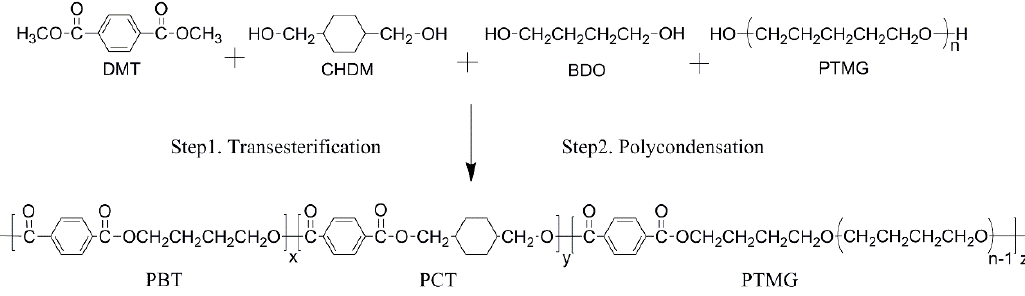
Figure 1. Synthesis route of the (PBT-co-PCT)-b-PTMG copolymers. Table 1. Compositions for the synthesis of the (PBT-co-PCT)-b-PTMG copolymers. Samples